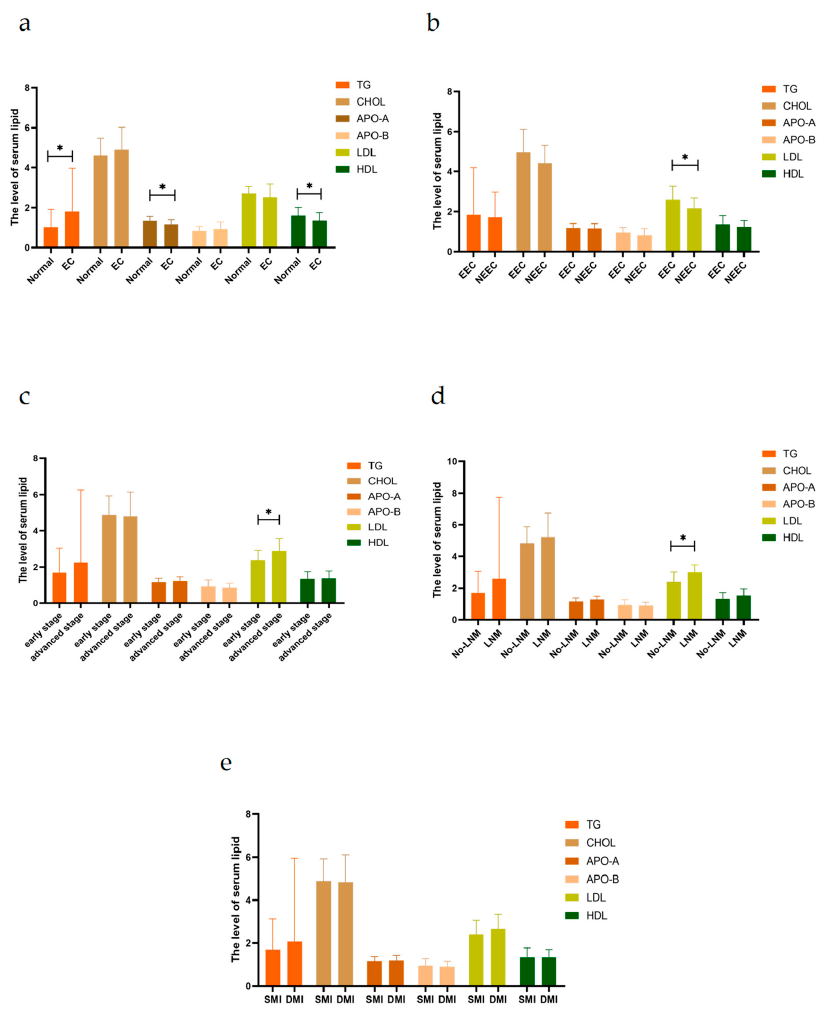
Figure 1. Serum lipid levels in patients with EC are associated with the progression of EC. ( a ) Compared to the healthy population, endometrial cancer (EC) patients had higher triglyceride (TG) lev- els and lower apolipoprotein A (APO-A) and high-density lipoprotein (HDL) levels. ( b ) Patients with endometrioid endometrial cancer(EEC) had higher low-density lipoprotein(LDL) levels than patients with non-endometrioid endometrial cancer(NEEC). ( c ) Patients with advanced-stage EC had higher LDL levels than those with early-stage EC. ( d ) Patients with lymph node metastasis (LNM) had higher LDL levels than those without LNM. ( e ) Patients with deep myometrial invasion ( ≥ 1/2 MI) had higher TG levels and lower LDL levels than those with shallow myometrial invasion MI (<1/2 MI), but there was no statistically significant difference.Abbreviations: TG Triglyceride;